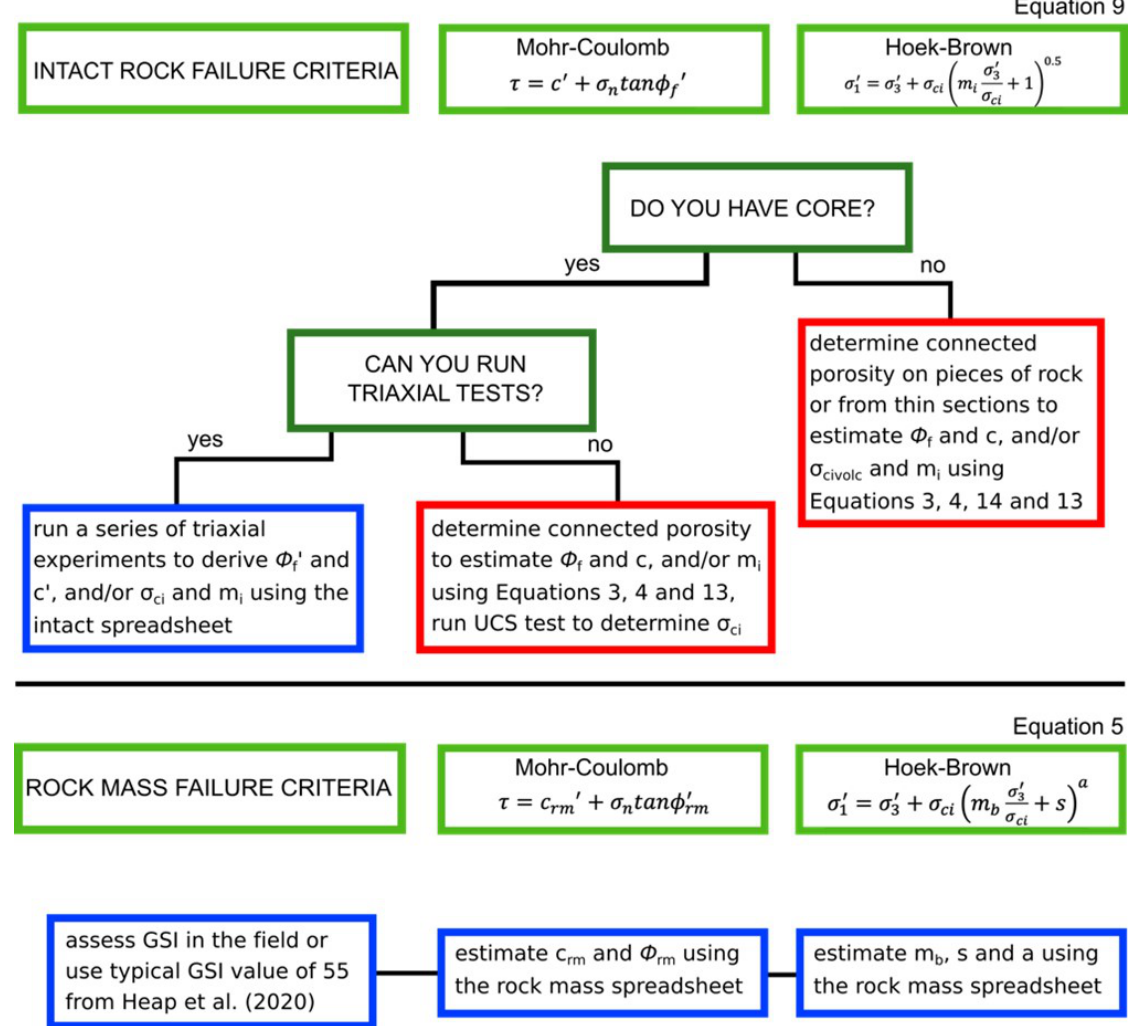
Figure 8: Flow chart of methodology for deriving Mohr-Coulomb and Hoek-Brown failure criterion parameters depending on intact rock and rock mass data